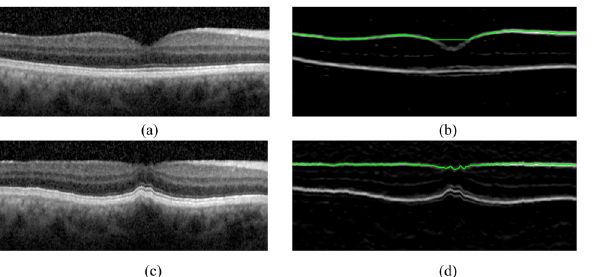
Fig 3. The shortest-path based graph search methodology prefers a geometric straight line and may fail to delineate the ILM boundary in the central region of the fovea. The ILM boundary can be detected correctly when the flattening operation uses the ILM border from a previous frame. Note that (a) and (c) are the raw OCT scans at the fovea and the resulting flattened image, respectively. (b) and (d) shows the results of the ILM boundary detection in (a) and